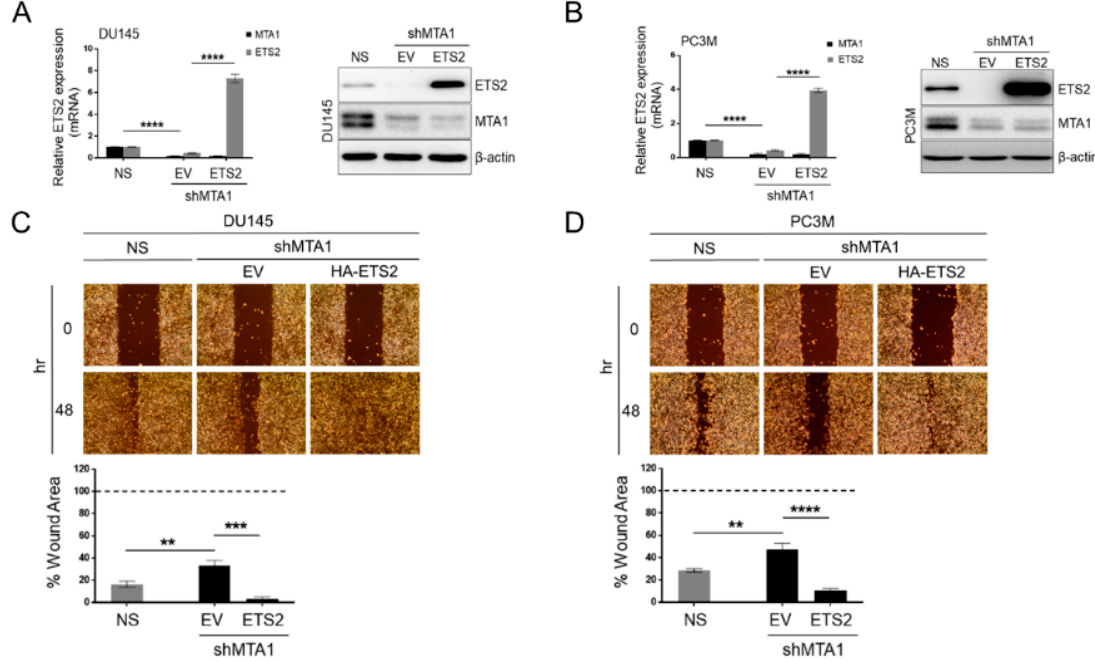
Figure 6. MTA1-mediated mobility of PCa cells is dependent on ETS2. ( A , B ) ETS2 overexpression in MTA1 knockdown DU145 and PC3M cells: left , mRNA levels were assessed by qRT-PCR; right, protein levels were assessed by Western blot. β -actin is a loading control. Data represent the mean ± SEM of three independent experiments. * p < 0.05; **p < 0.01; *** p < 0.001; **** p < 0.0001 (two-way ANOVA). ( C , D ) Representative images showing migration ability of DU145 and PC3M MTA1 expressing (NS) and MTA1 knockdown (shMTA1) cells overexpressing ETS2. Bottom, quantitation of wound widths as percentage of wound area using ImageJ software is shown for each cell line. Data represent the mean ± SEM of six separate wounds and three independent experiments. * p < 0.05; ** p < 0.01; *** p < 0.001; **** p < 0.0001 (one-way ANOVA).